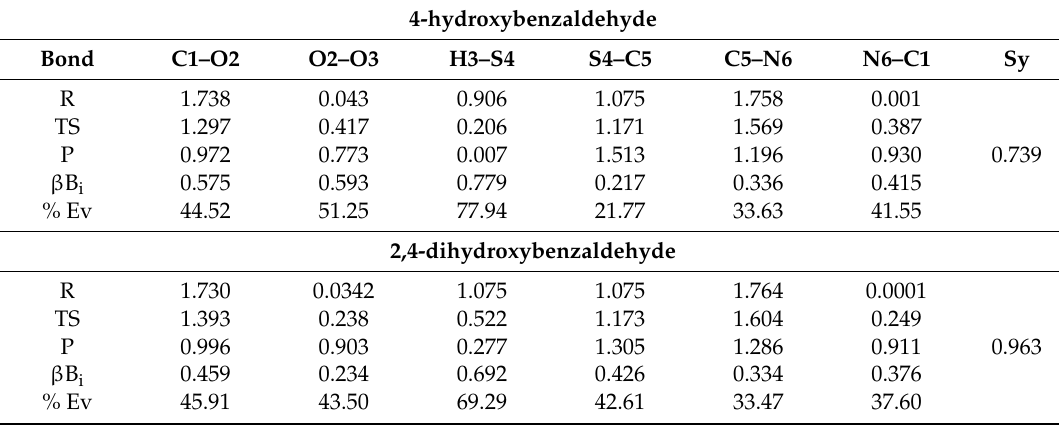
Table 5. Wiberg bond indexes of R, TS, and P, for the Biginelli reaction of 4-hydroxybenzaldehyde